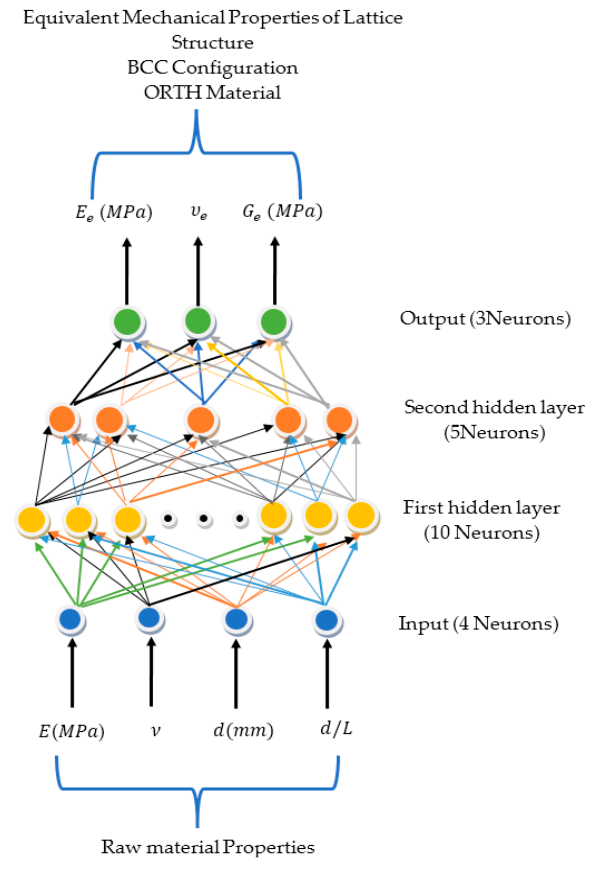
Figure 9. the structure of the NN model for BCC configuration. Figure 9. The structure of the NN model for BCC